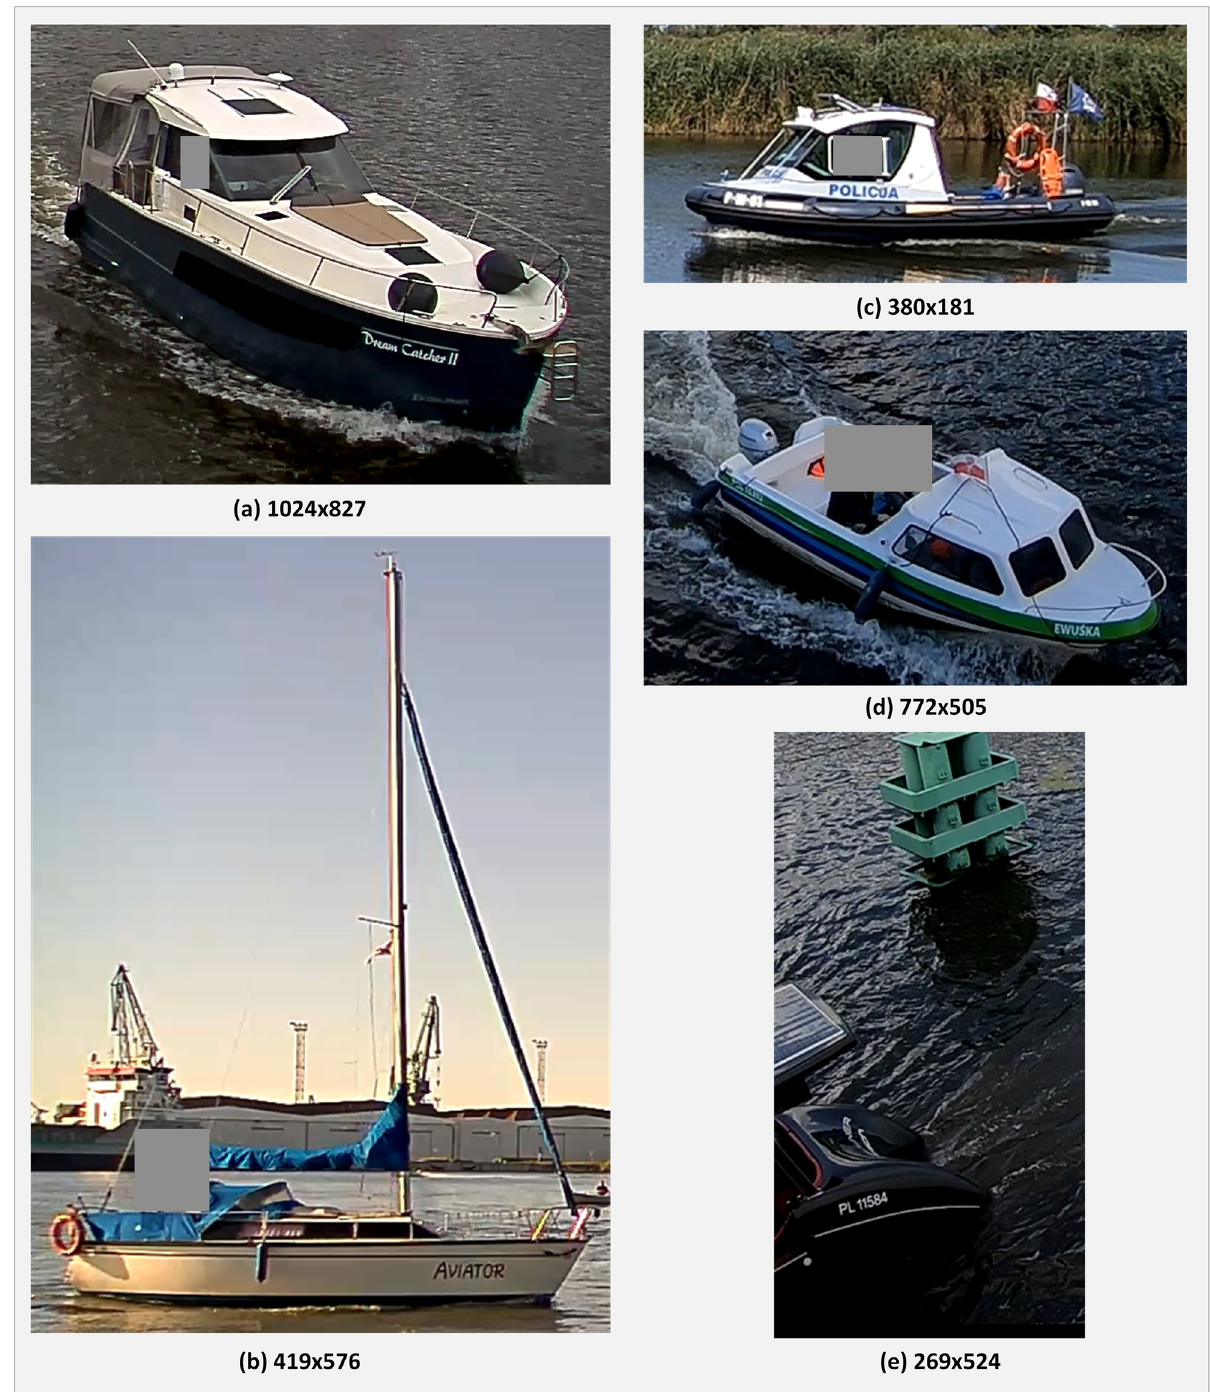
Fig 4. Example images from dataset A with the size in pixels configured to work in the following settings: Mode 1, mode 2, mode 3, mode 13, mode 23, and mode 123. Mode 12 of the setting was rejected after preliminary tests because it returns low-quality results.